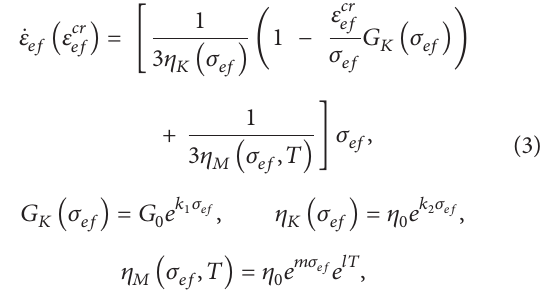
Table 4: Calculation values of strength and elastic parameters for anhydrite and neighboring layers used for numerical calculations [13]. Rock mass type 𝑅 𝑐 (MPa) 𝑅 𝑟 (MPa) Sandstone Shale 1.47 Anhydrite upper Anhydrite lower Dolomite, limestone